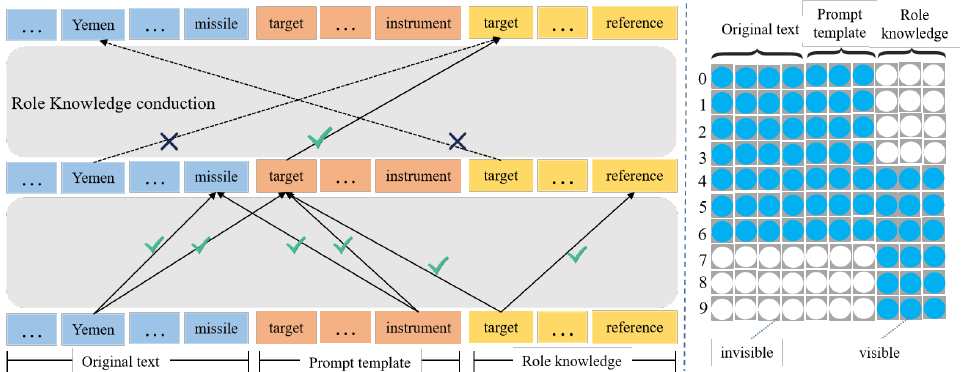
Figure 3. Role knowledge guidance mechanism. Interaction between original text, templates, and roles, where (cid:88) indicates visible and × indicates